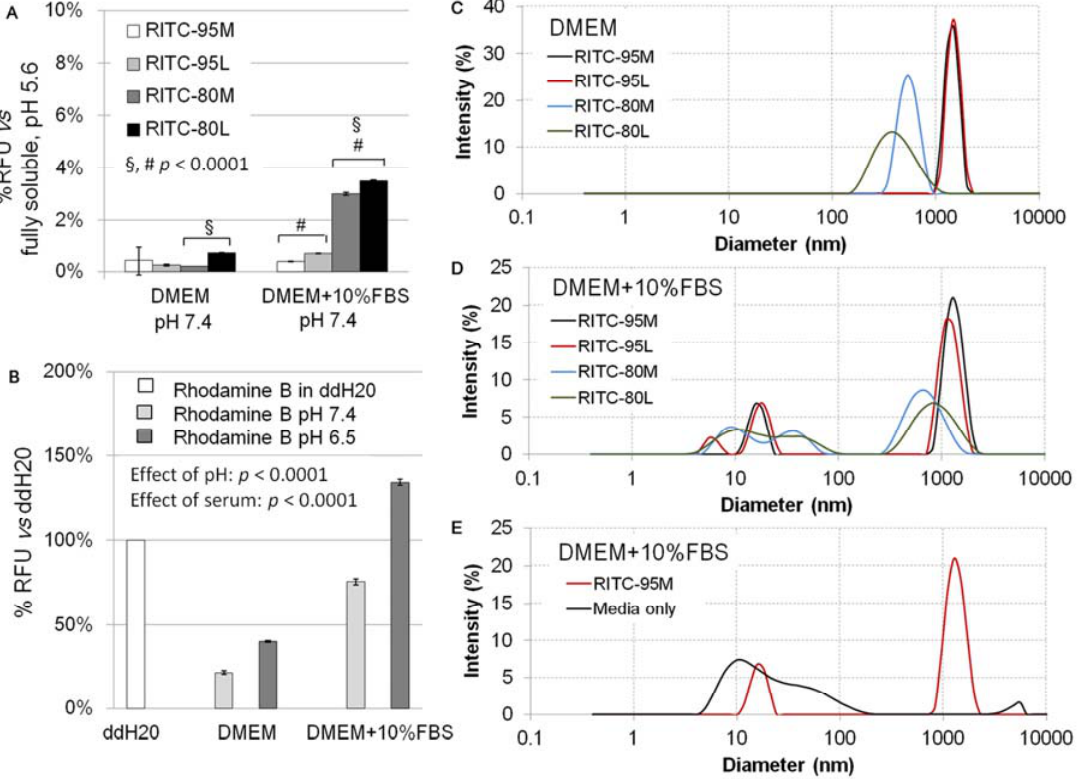
Figure 4. Residual neutral-soluble RITC-chitosan fluorescence in media pH 7.4 vs. RITC-chitosan fluorescence in water pH 5.6 defined as 100% ( A ), % rhodamine B fluorescence in culture media vs. in water defined as 100% ( B ), and hydrodynamic chitosan particle size distribution in DMEM pH 7.4 ( C ) and DMEM+10% FBS pH 7.4 ( D ); Panel E shows